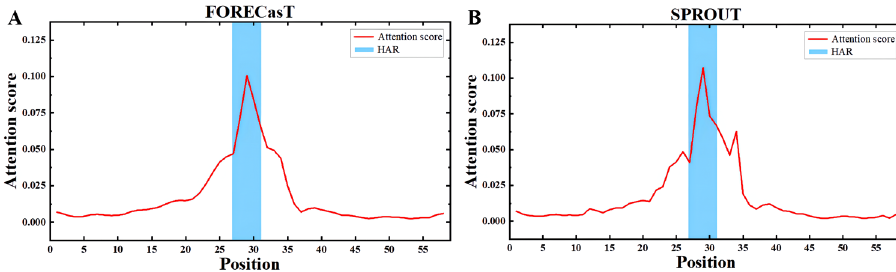
Figure 5. High-attention regions (HAR) [26], indicating important sequence loci for predicting repair outcomes. ( A , B ) The distribution of attention scores for all input sequences in the test data of FORECasT and SPROUT, showing the average importance of the different loci calculated on these sequences, for predicting repair